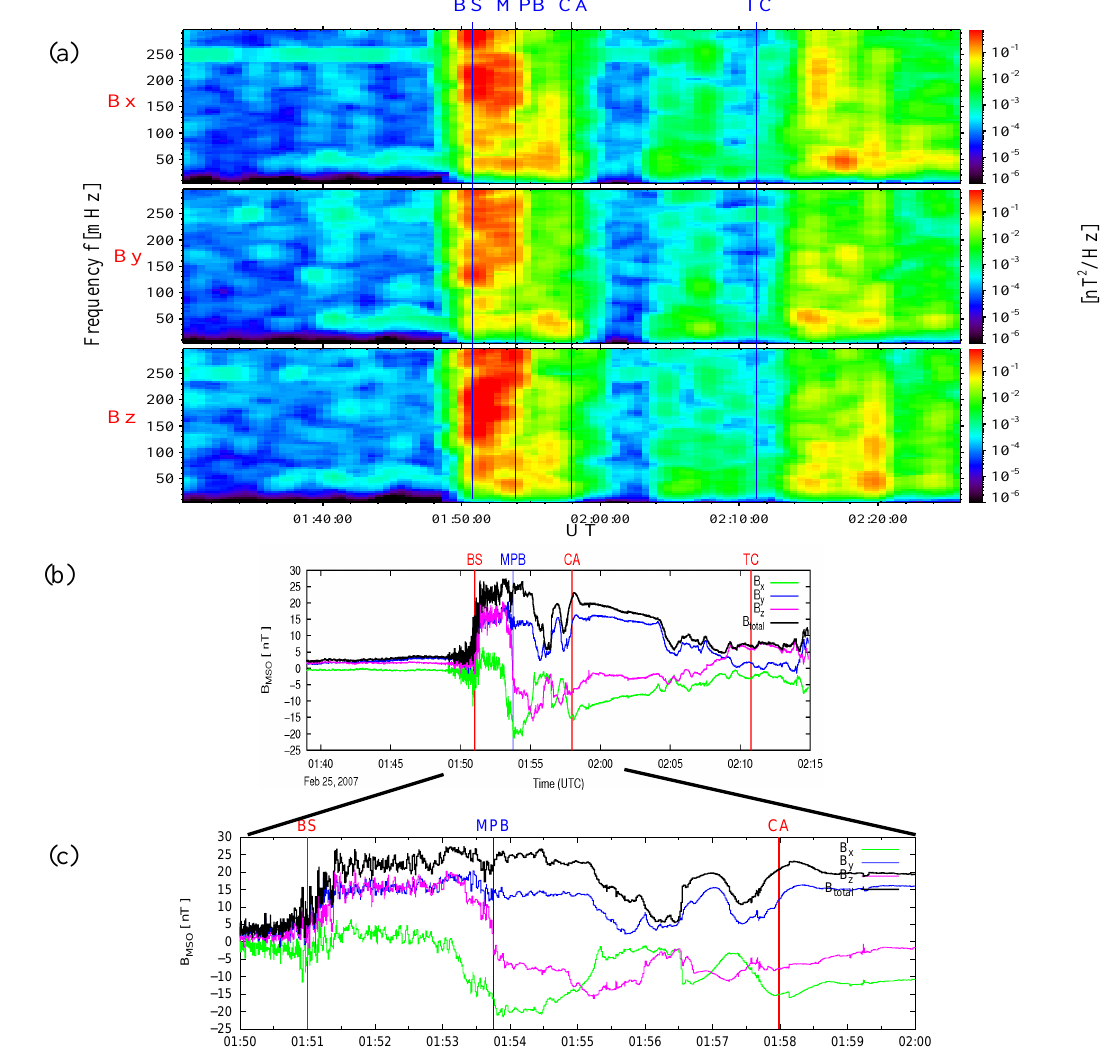
Fig. 2. Magnetic field data measured by ROMAP, (a) Dynamic Frequency Spectra, (b) data in MSO coordinates, (c) detailed plot of data. About 10min before the bow shock is crossed, ROMAP measures low frequency waves between 40–70mHz, proton upstream waves which were also reported by Brain (2004) . After detecting a fore shock region at around 01:49UT, ROMAP crosses the bow shock at 01:51UT where the magnetic field jumps quite strongly from 4nT in the solar wind to around 10nT in fore shock region and to 25nT behind the bow shock. The fluctuations appear in all frequency ranges. At 01:53:45UT Rosetta enters the MPB, where fluctuations are clearly reduced. At 01:58UT Rosetta reaches its CA with 262km above surface. A minute before, already under 300km above surface, fluctuations by weak crustal magnetic fields are measured (see also Fig. 4). Behind the tail crossing (TC) fluctuations again are increased in all three components. The signal at around 250mHz is a spacecraft-generated artifact. Note that the offsets of the three components could not be determined exactly. However, the data are coherent, especially the clear negative B x component in the magnetosheath leads to the explanation that IMF had a strong B z component (see Fig. 10). This behavior could also be verified by hybrid simulation results (see Fig.